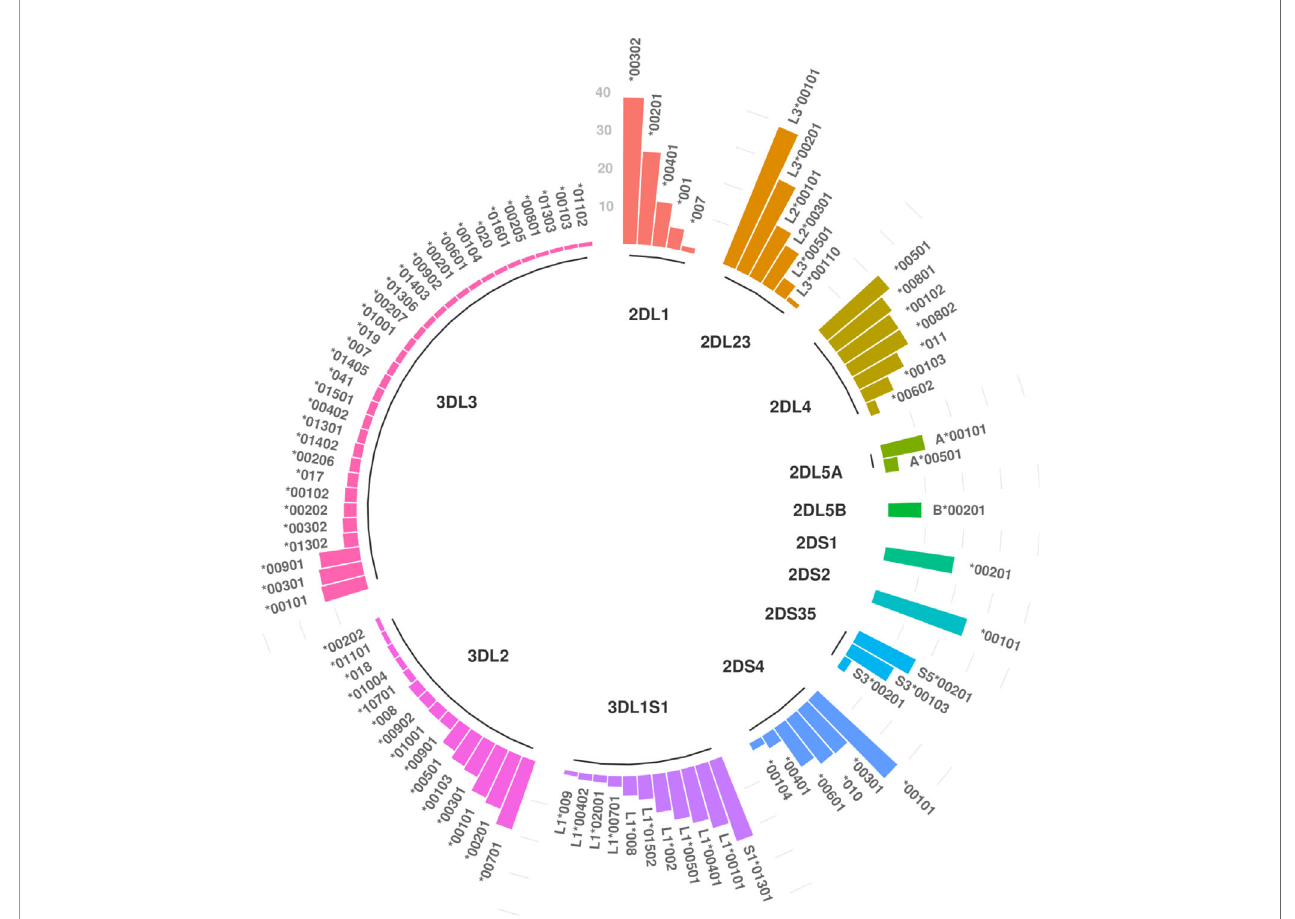
FIGURE 4 | Overview of the most common alleles in European-Americans. Only alleles with frequencies greater than 1% are shown. For full list of allelic frequencies, see Supplementary Table 2